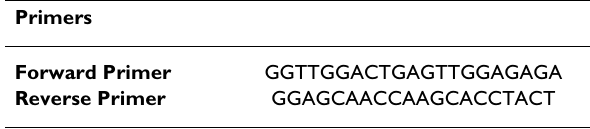
Table 2: Primer sequences used for sequencing